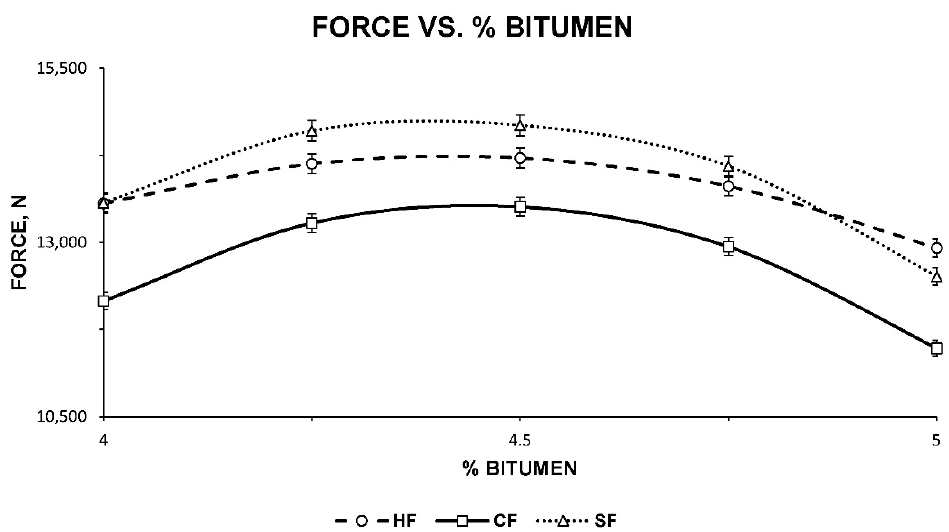
Figure 8. Marshall stability of the HF, CF and SF families of bituminous mixtures according to bitumen percentage.